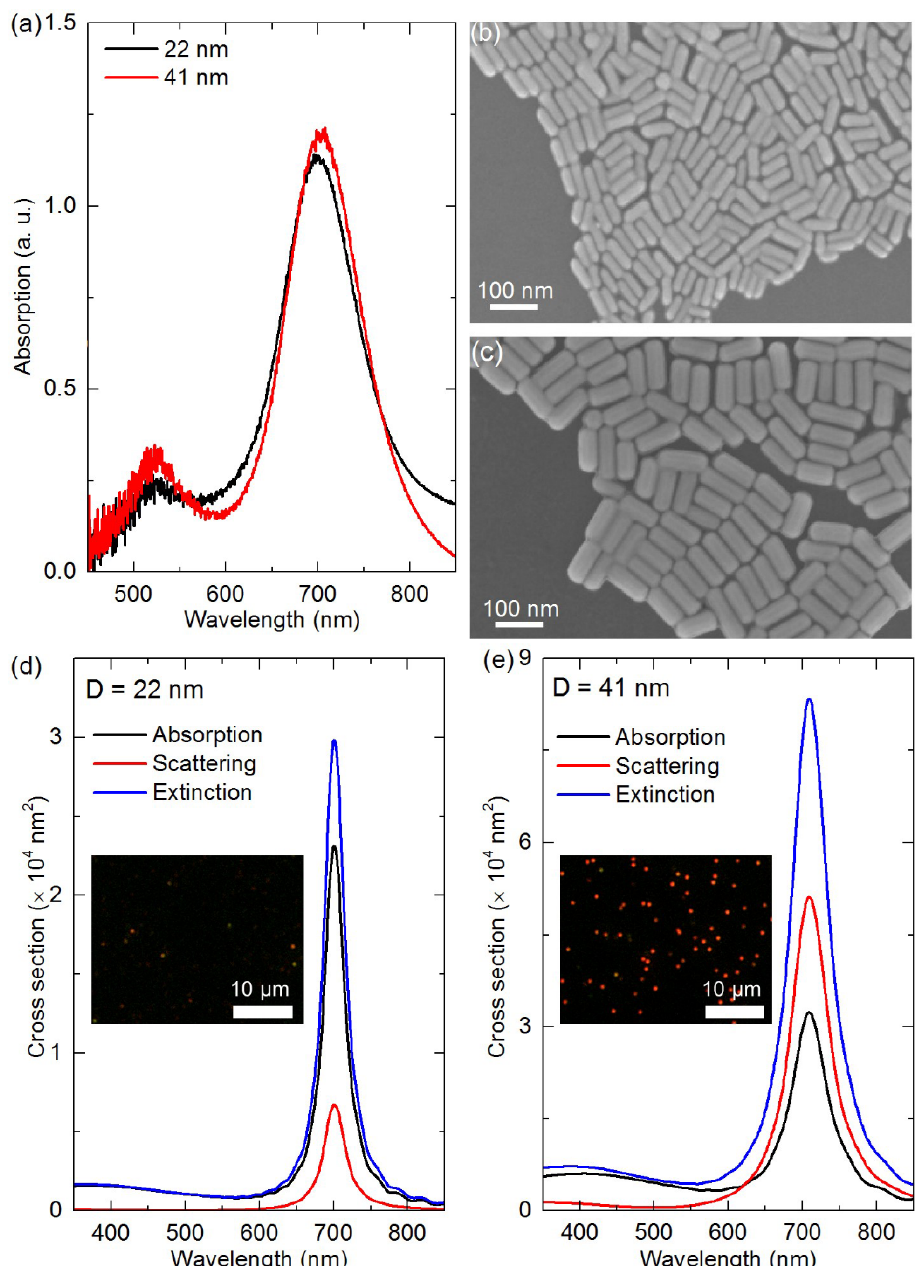
Figure 2. ( a ) Absorption spectra of Au nanorods with the diameters of 22 and 41 nm in water; ( b ) SEM image of Au nanorods with a 22 nm diameter; ( c ) SEM image of Au nanorods with a 41 nm diameter; ( d ) simulated absorption, scattering and extinction spectra for Au nanorods with a 22 nm diameter; ( e ) simulated absorption, scattering and extinction spectra for Au nanorods with a 41 nm diameter. The insets in ( d ) and ( e ) are dark-field scattering images of individual Au nanorods deposited on glass substrates.